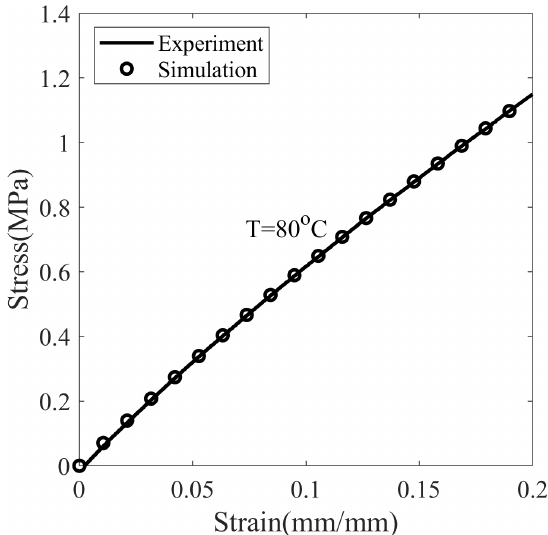
Figure 4. The stress–strain response of SMP deformed with a strain rate of 0.0013 s − 1 at T = 80 °C in the rubbery